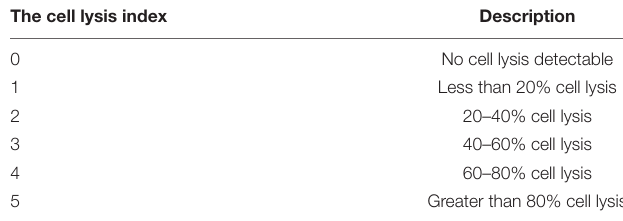
TABLE 3 | The cell lysis index.